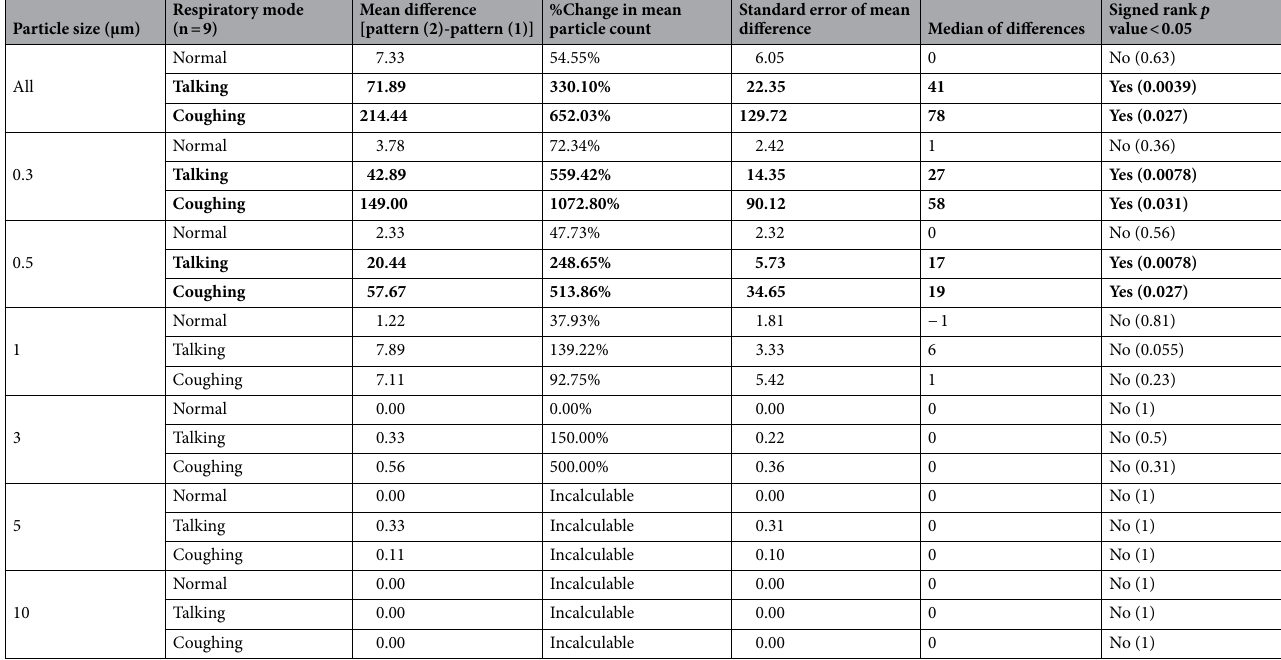
Table 1. Differences in particle counts by particle size and respiratory mode between experiment patterns 1 and 2. Bold rows highlight the scenarios in which significant differences were observed.